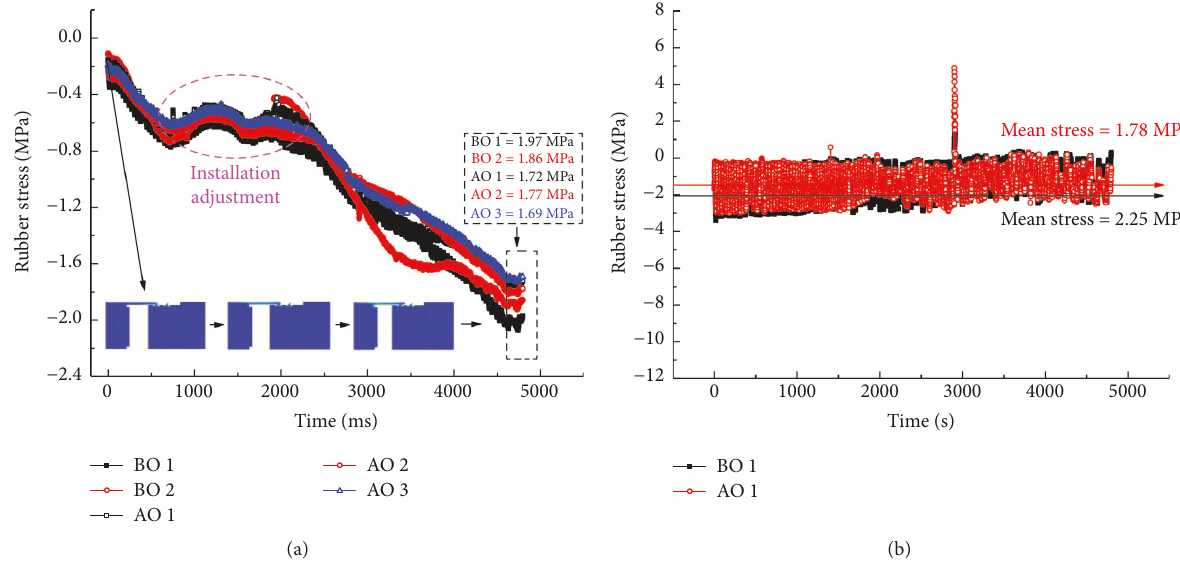
Figure 29: Layout of measurement points. (a) The installation process. (b) The jacking process.